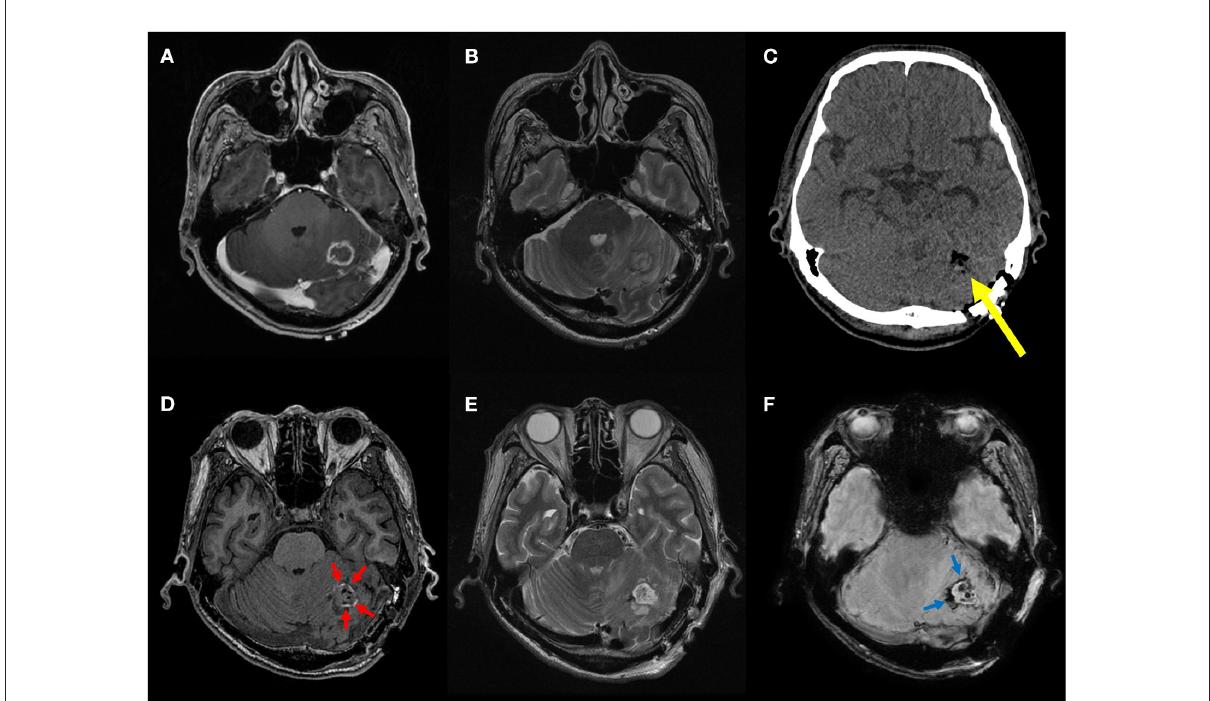
FIGURE3 A representative case of minimal residual blood at the resection site. Preoperative T1 contrast-enhanced (A) and T2-weighted MR images (B) of a 62-year-old male patient with non-small cell lung cancer show a small rim-enhancing metastatic tumor in the left cerebellar hemisphere with peritumoral edema. On postoperative CT image (C) , only air bubbles are seen in the resection cavity without discernible hemorrhage (yellow arrow). On postoperative MR images, only thin T1 hyperintense (red arrows) and T2* hypointense rim (blue arrows) is seen along the resection margin without space-occupying hematoma on T1-weighted (D) , T2-weighted (E) , and susceptibility-weighted images (F) . This was considered absence of postoperative intracranial hemorrhage, and the patient did not experience postoperative delirium.